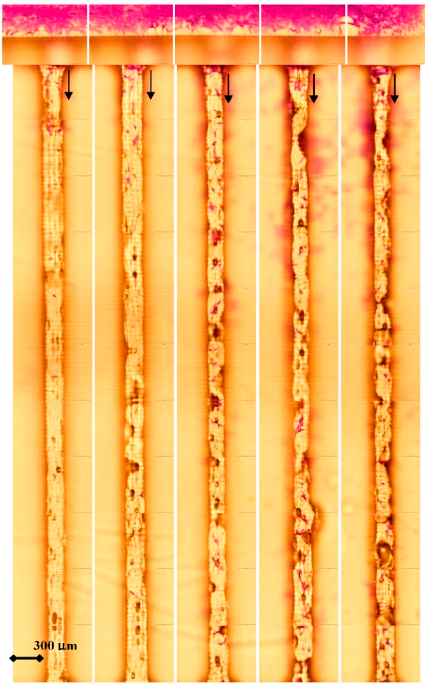
Figure 4. Results from the motility study of cells cultured on the fractal microsystem pre-treated with TFs medium: Origin well full of cells and cell distribution of cells along the channels. Fractal dimension and roughness increase from left to right.